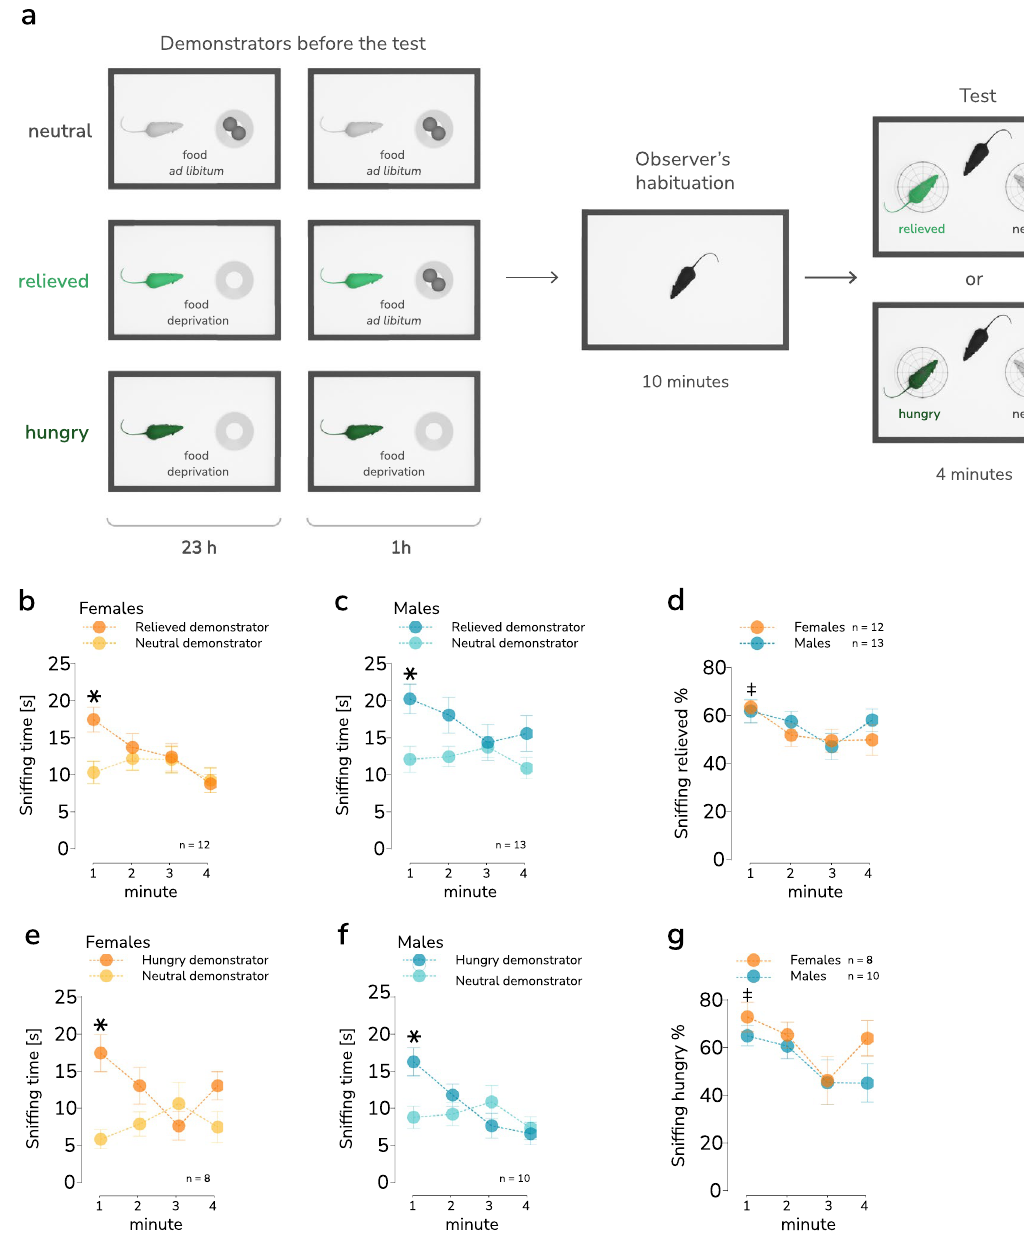
Figure 3. Affective state discrimination. ( a ) A schematic representation of the task. ( b–c ) The time spent by the demonstrator sniffing the relieved (darker points) and neutral (lighter points) demonstrators, female and male mice, respectively. Each point represents the mean time spent sniffing respective partners during a 1 min interval (bin). The whiskers represent s.e.m. values, and significant differences between the mean time spent sniffing in the first 1 min interval are shown with a “*” (ANOVA with repeated measures; post hoc Šídák’s multiple comparisons test, p < 0.05). ( d ) No difference between female and male mice in preference for sniffing the relieved demonstrator over the neutral demonstrator. The points represent mean values over 1 min intervals, whiskers represent the s.e.m. Significant differences vs. 50% during the first 1 min interval in both female and male mice are indicated by a “‡” (one-sample t-test p < 0.05). ( e–f ) The time spent by the demonstrator sniffing the hungry (darker points) and neutral (lighter points) female and male demonstrators, respectively. Each point represents the mean time spent sniffing respective partners during a 1 min interval (bin). The whiskers represent s.e.m. values, and significant differences between the mean time spent sniffing in the first 1 min interval are shown with a “*” (ANOVA with repeated measures; post hoc Šídák’s multiple comparisons test, p < 0.05). ( g ) No difference between female and male mice in preference for sniffing the hungry demonstrator over the neutral demonstrator. The points represent mean values over 1 min intervals, whiskers represent the s.e.m. Significant differences versus 50% during the first 1 min interval in both female and male mice are indicated by a “‡” (one- sample t-test p < 0.05). The group sizes are indicated below the